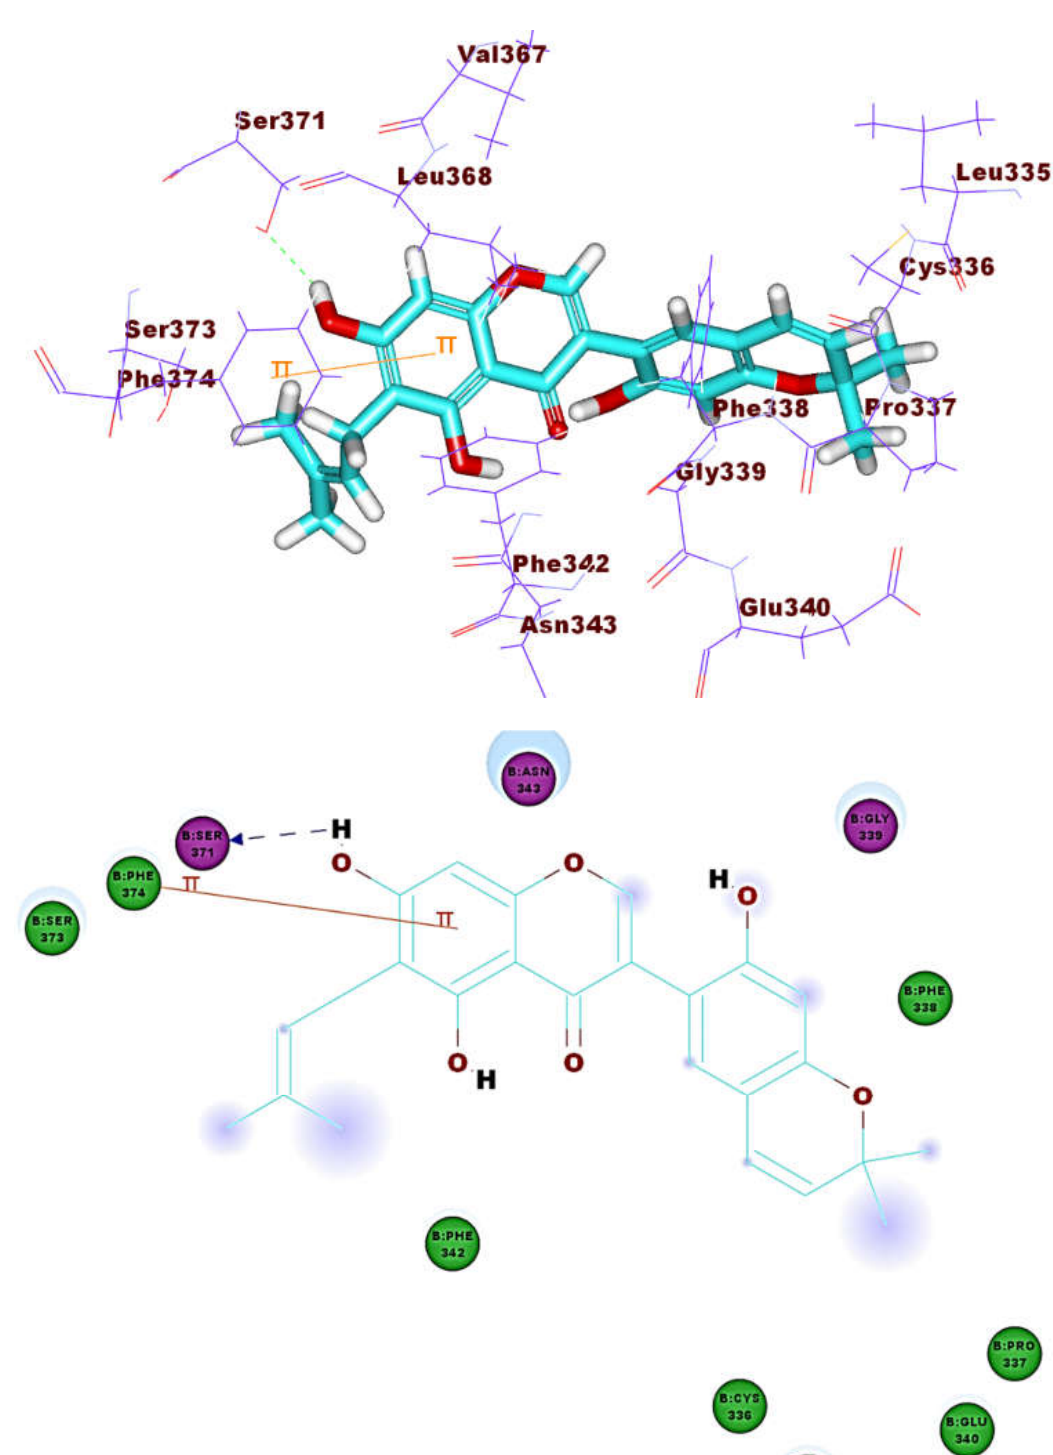
Figure 7. Compound 33 docked into ACE-2, forming one H. bond with Ser371.